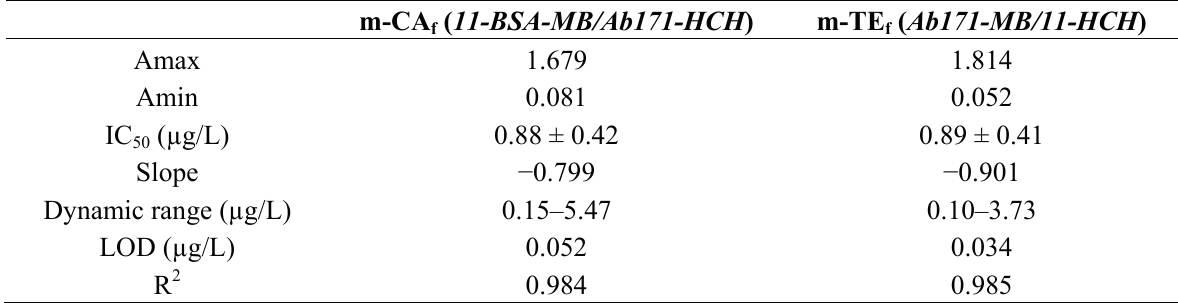
Table 2. Features of the different m-ELISA formats using the immunoreagents produced and the biomodified magnetic beads.